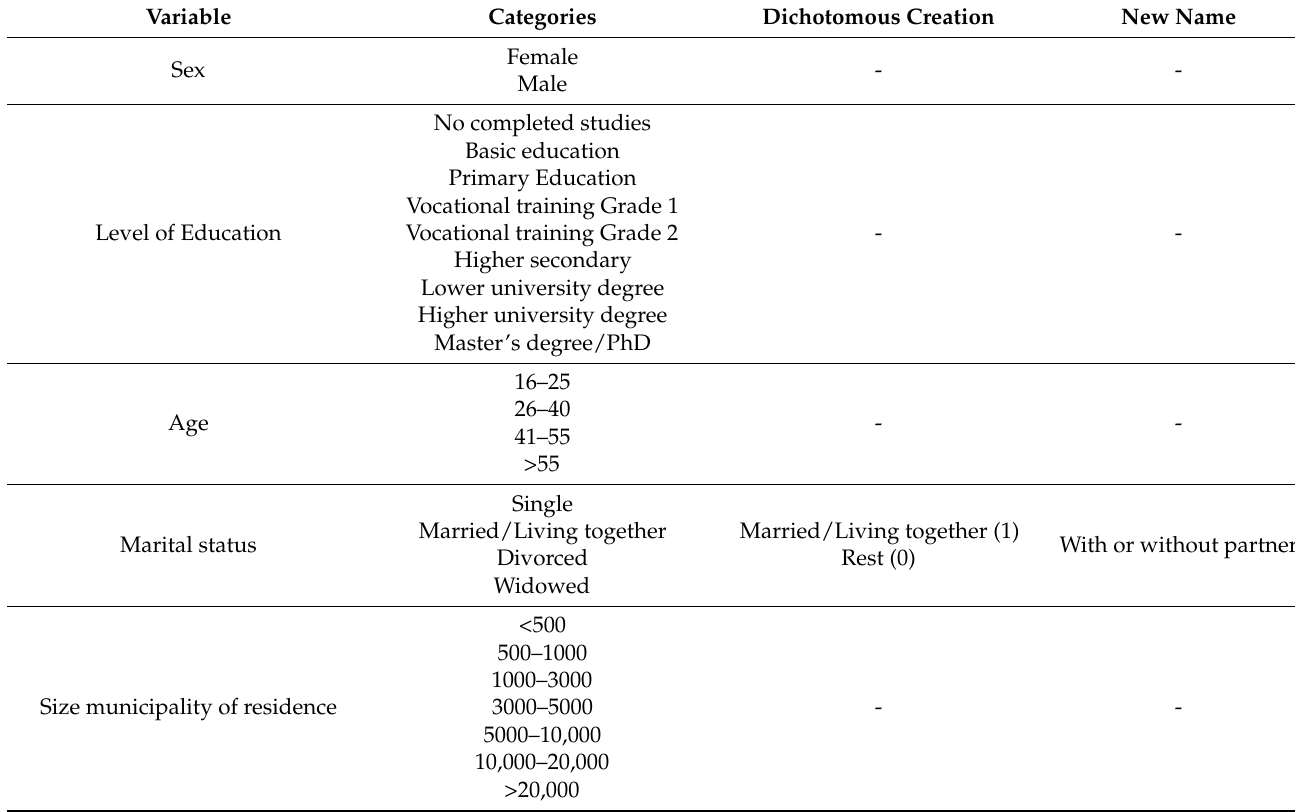
Table A1. Description of independent variables included in the multiple regression full model. Variable